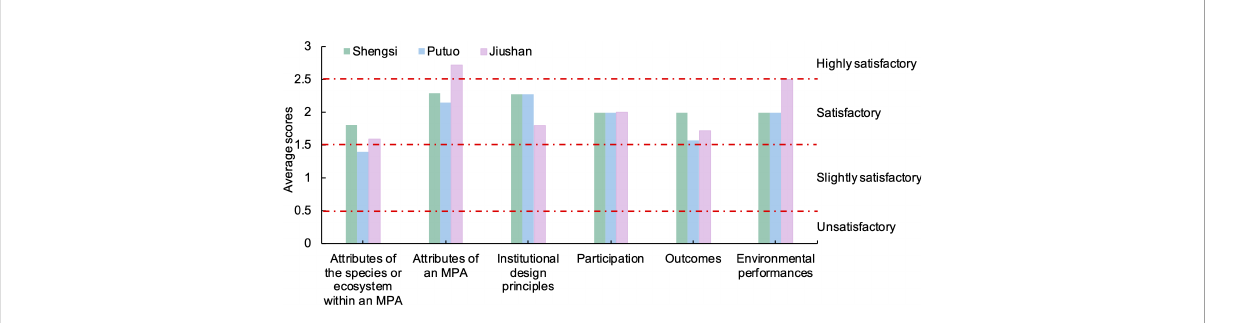
FIGURE 4 The average scores of potential drivers, outcomes and environmental performance within outcomes for the three MPAs in the Yangtze River Delta. The dashed red lines mark score levels; [0, 0.5) = unsatisfactory, [0.5, 1.5) = slightly satisfactory, [1.5, 2.5) = satisfactory [2.5, 3] = highly